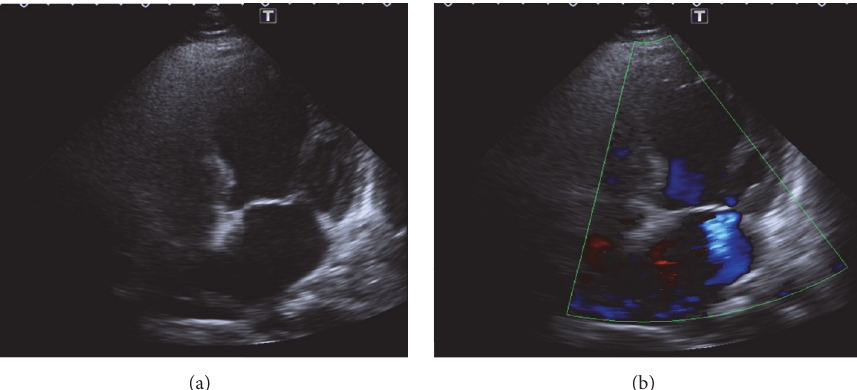
Figure 2: (a) Left ventricle apical hypokinesis during the systolic phase. (b) Mild to moderate mitral valve regurgitation was noted.